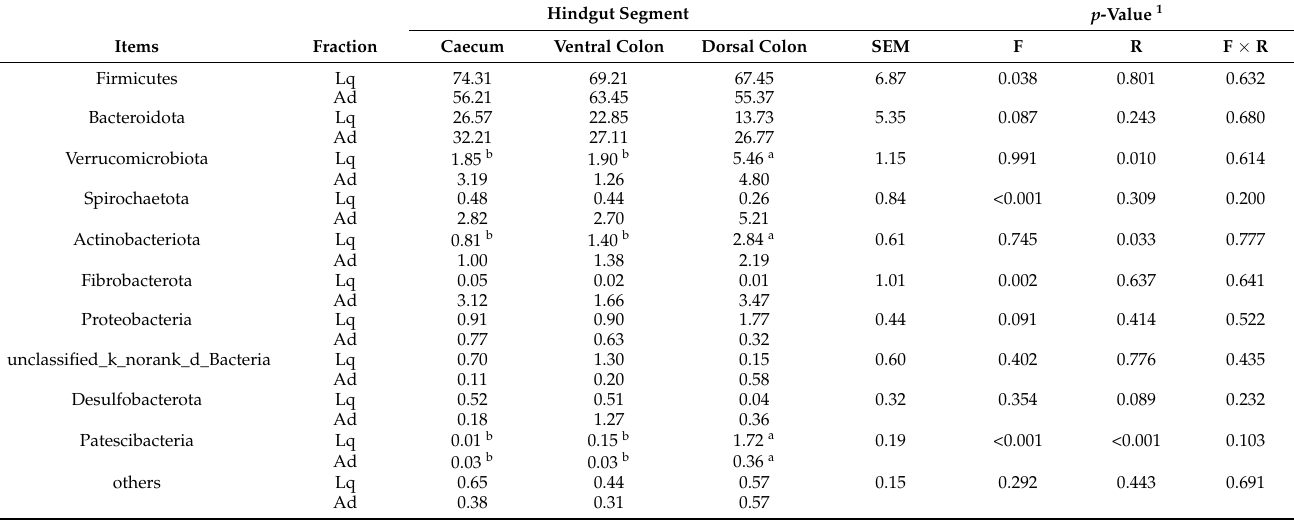
Table 3. The relative abundance of bacterial community composition at the phylum level (top 10) in the liquid phase (Lq) and adherent fraction (Ad) within the donkey caeco-colic ecosystem. Hindgut Segment p -Value 1